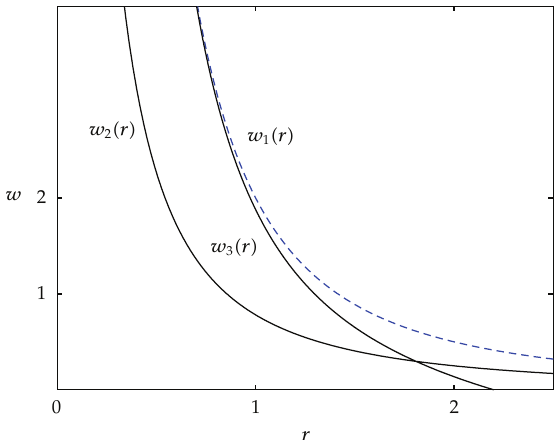
Figure 2: Solutions of (cid:3) 1.3 (cid:4) – (cid:3) 1.8 (cid:4) such that r min (cid:5) 0 when (cid:3) N,p (cid:4) (cid:5) (cid:3) 3 , 2 (cid:4) ; w 1 (cid:3) r (cid:4) is defined in (cid:3) 1.4 (cid:4) ; w 2 (cid:3) r (cid:4) and w 3 (cid:3) r (cid:4) satisfy parts (cid:3) ii (cid:4) and (cid:3) iii (cid:4) of Specific Aim 3. Also, w 2 (cid:3) r (cid:4) satisfies part (cid:3) i (cid:4) of Theorem 2.2, with (cid:5) 0 and r (cid:5) ∞ . w (cid:3) r (cid:4) is a solution satisfying part (cid:3) iv (cid:4) of Theorem 2.2, with r r min max 3